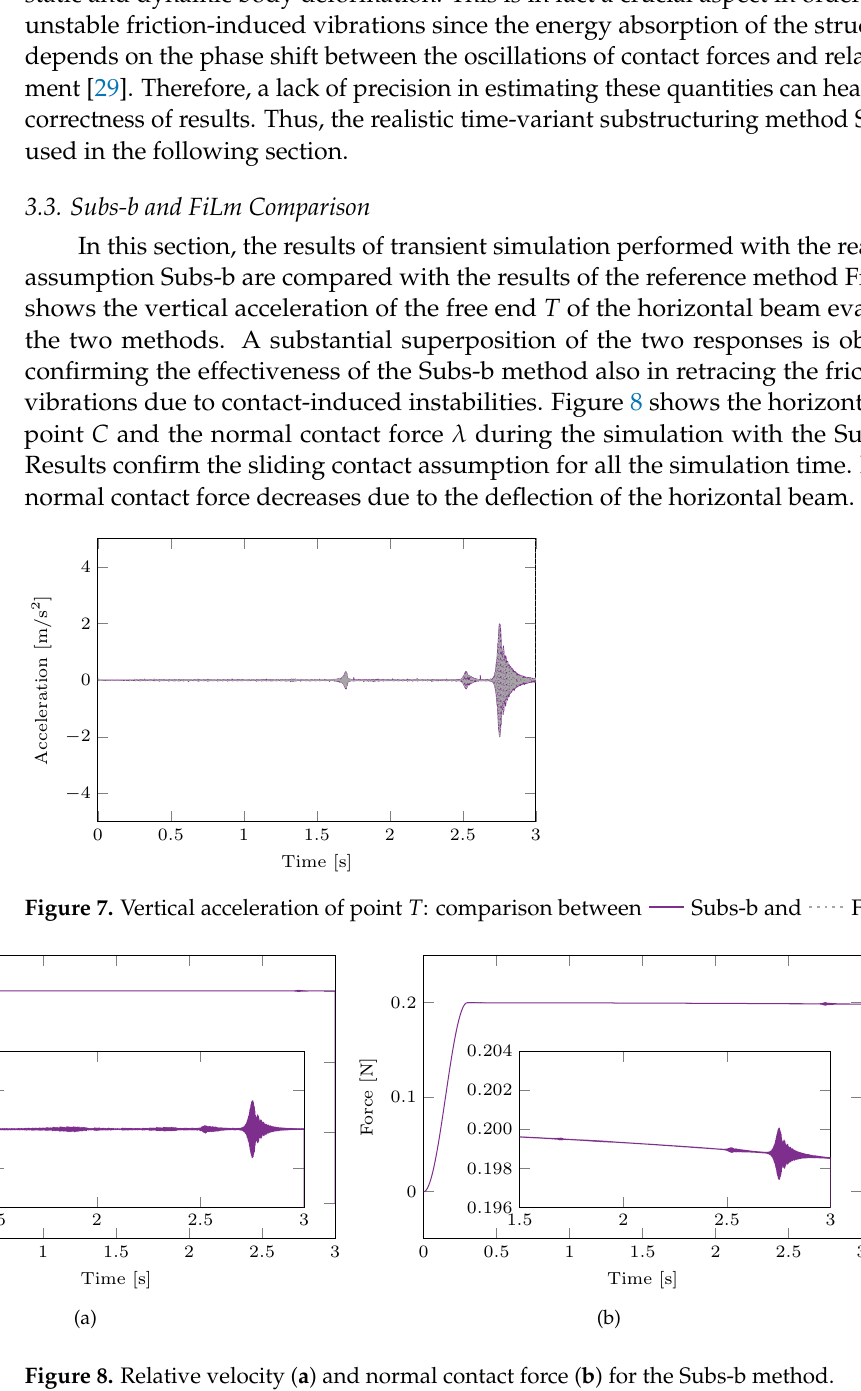
Figure 8. Relative velocity ( a ) and normal contact force ( b ) for the Subs-b